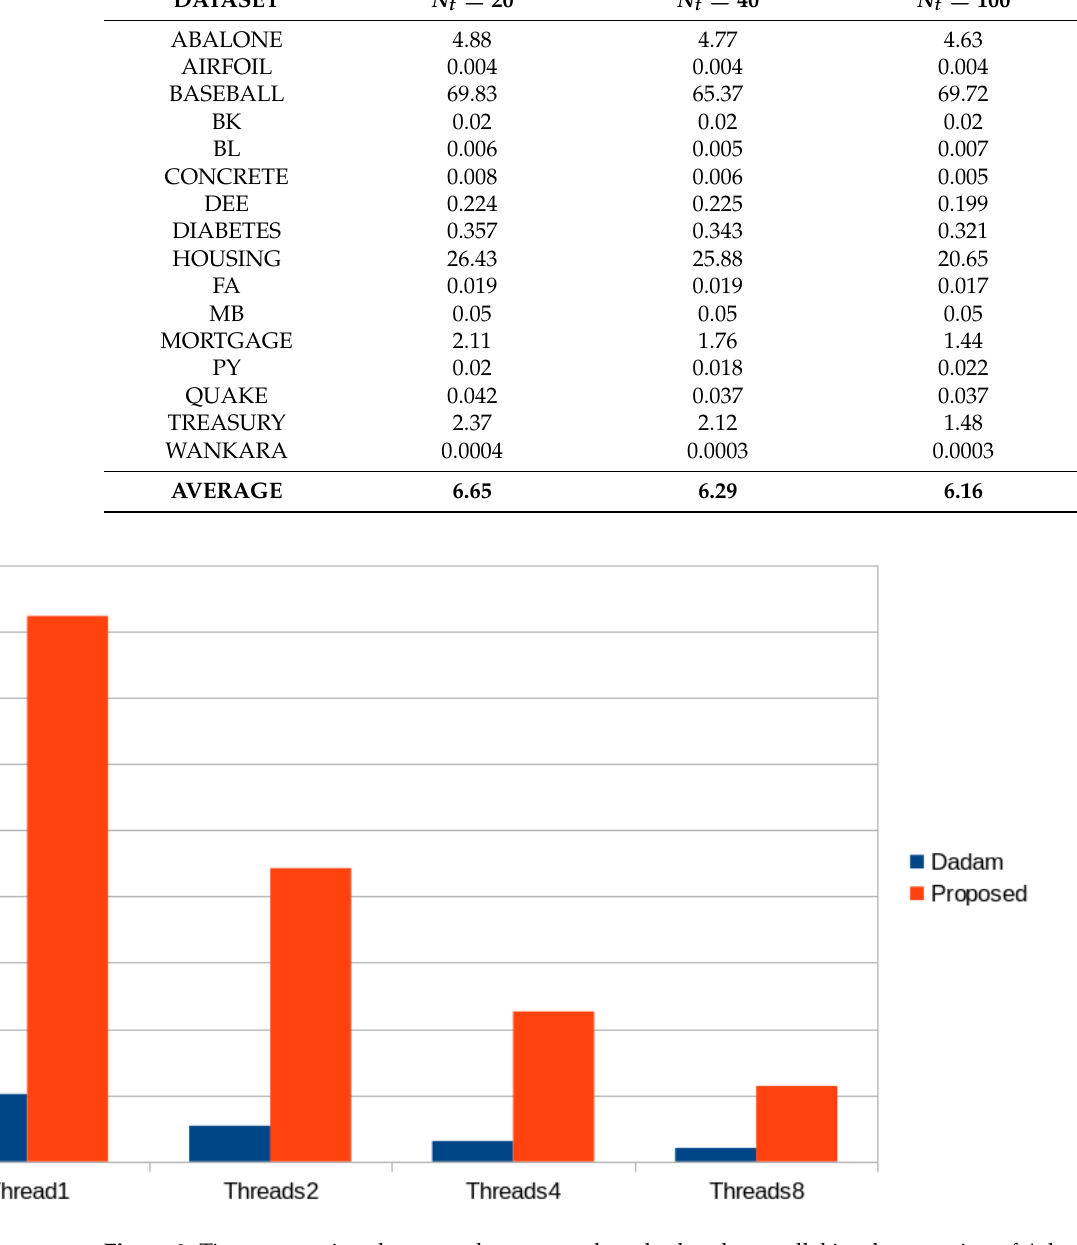
Figure 2. Time comparison between the proposed method and a parallel implementation of Adam algorithm. The comparison is made for the dataset